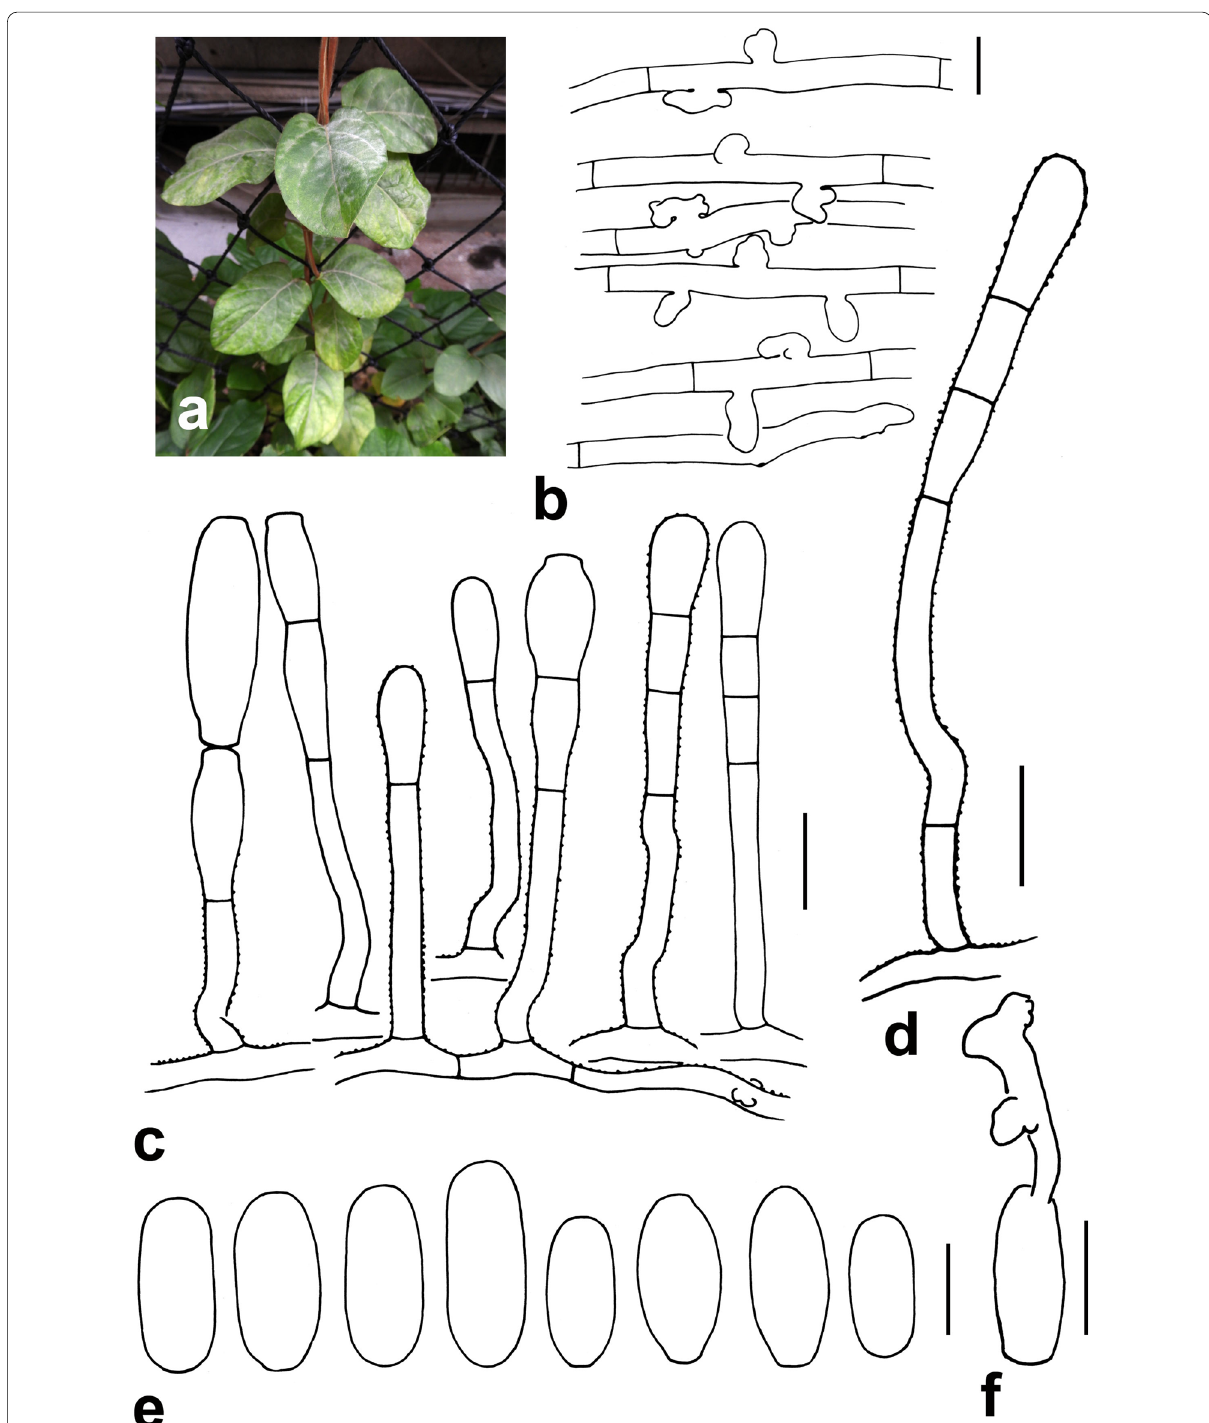
Fig. 8 Erysiphe lonicerae on Lonicera japonica (R. Kirschner 4712, except a with appressoria. c Conidiophores with straight or curved foot cell (surface ornament not shown in all conidiophores). d Exceptional conidiophore with curvature above foot cell. e Conidia. f Conidium with appressoria on the germination hypha. Scale bars b